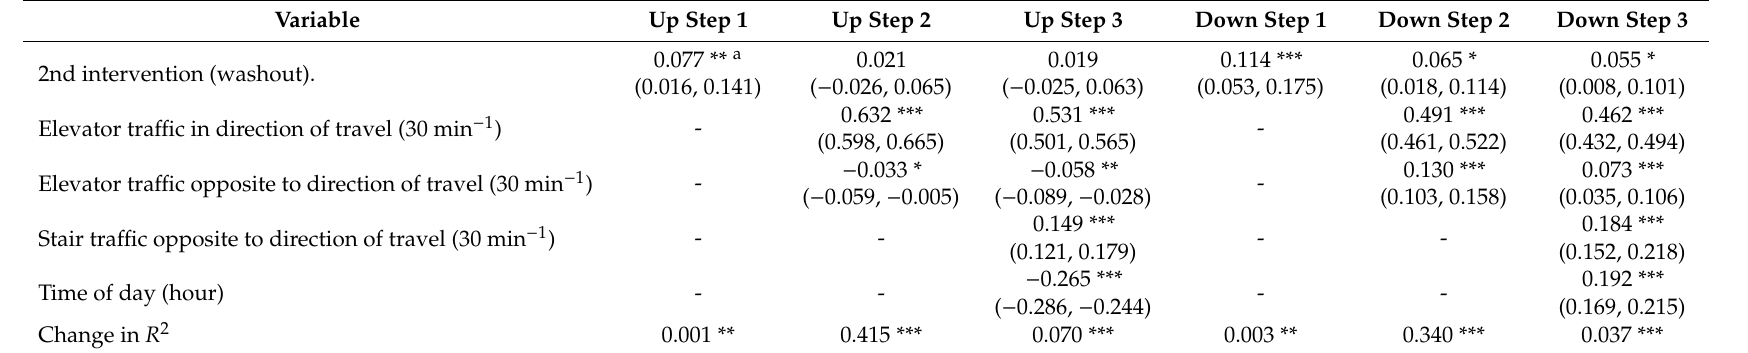
Table 6. Summary of the e ff ects of variables on stair use in Barcelona during the second intervention phase.